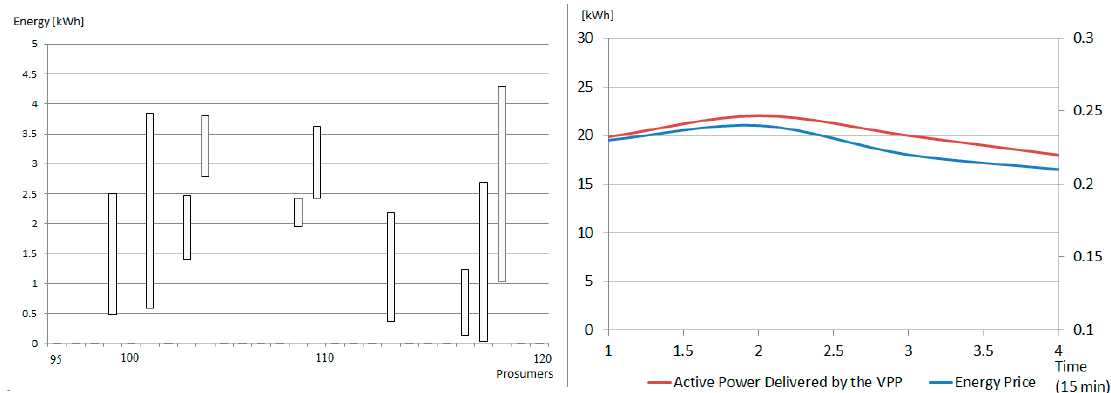
Figure 9. [LEFT] Prosumers selected in the VPP coalition from microgrid3 and [RIGHT] VPP energy generation and energy price in the market.